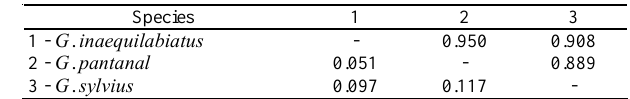
Table 5. Genetic identity (above diagonal) and genetic distance (below diagonal) of Nei (1972), for three Gymnotus species from Caracu stream, Paraná State,